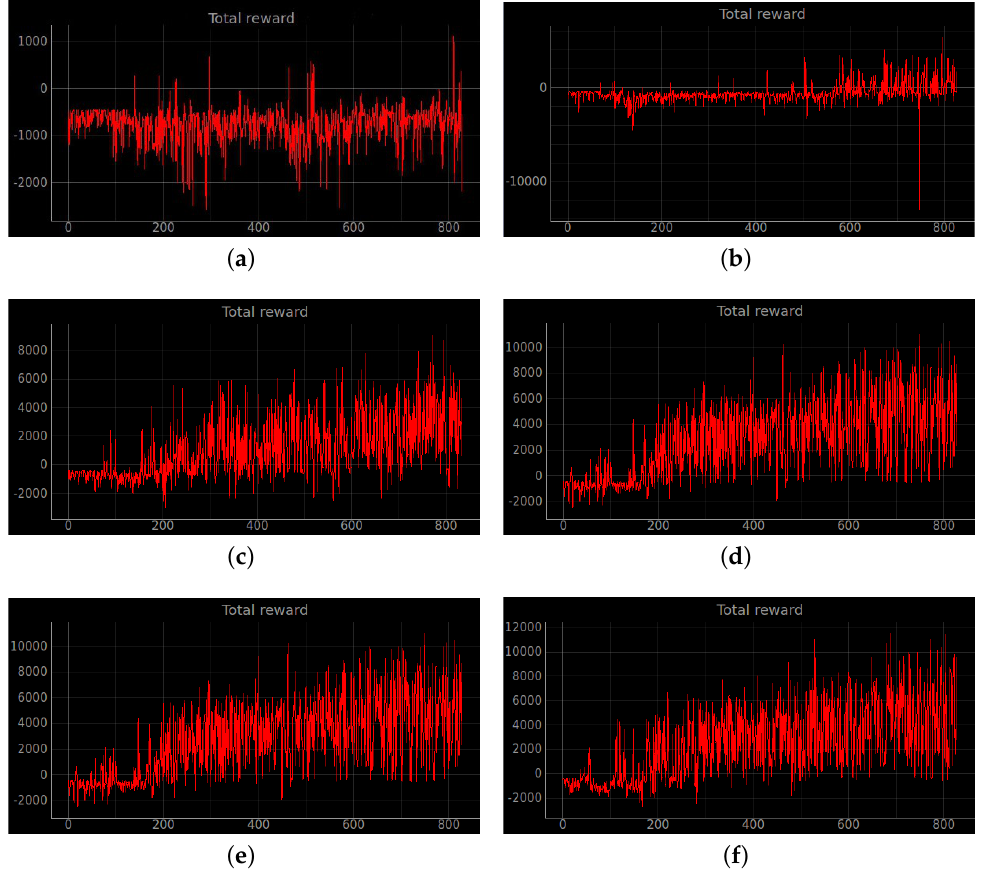
Figure 12. The curve of the cumulative sum of all rewards per episode for stage 4. ( a ) Original